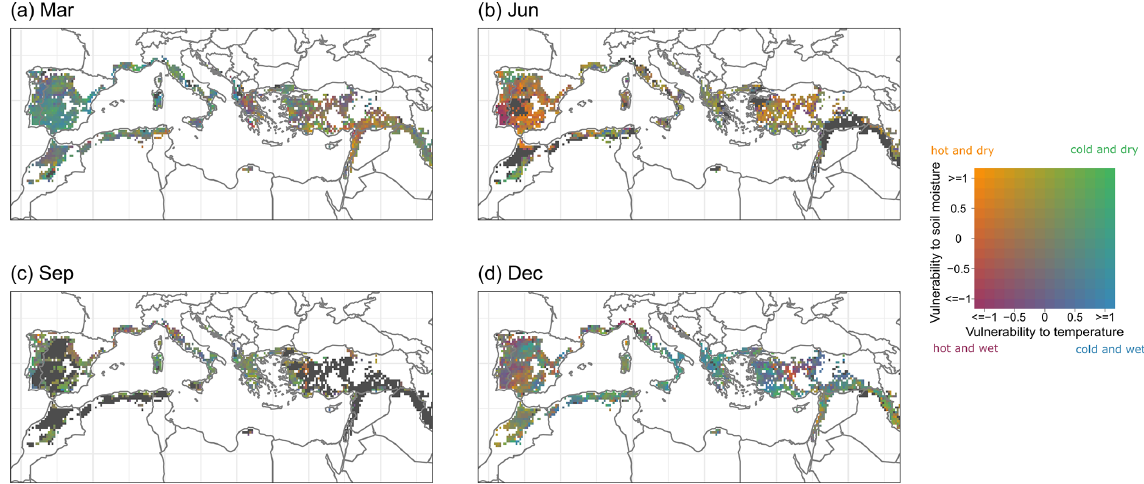
Figure 7. Average monthly vulnerability to soil moisture (ESA CCI) and temperature (ERA5-Land) in the Mediterranean Basin for (a) March, (b) June, (c) September and (d) December. Grid points without any events during the respective month are displayed in